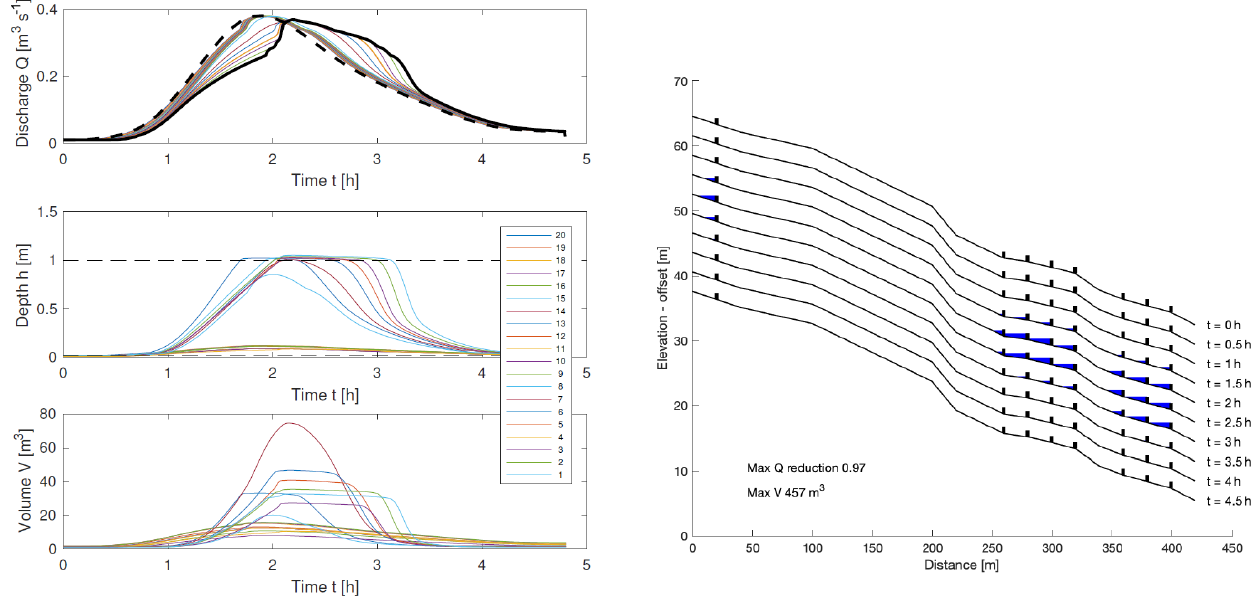
Figure 15. Model run with eight dams, chosen to be sited on segments with lower slopes. The reduction peak discharge is 97% of the inflow, and the maximum volume stored is 457m 3